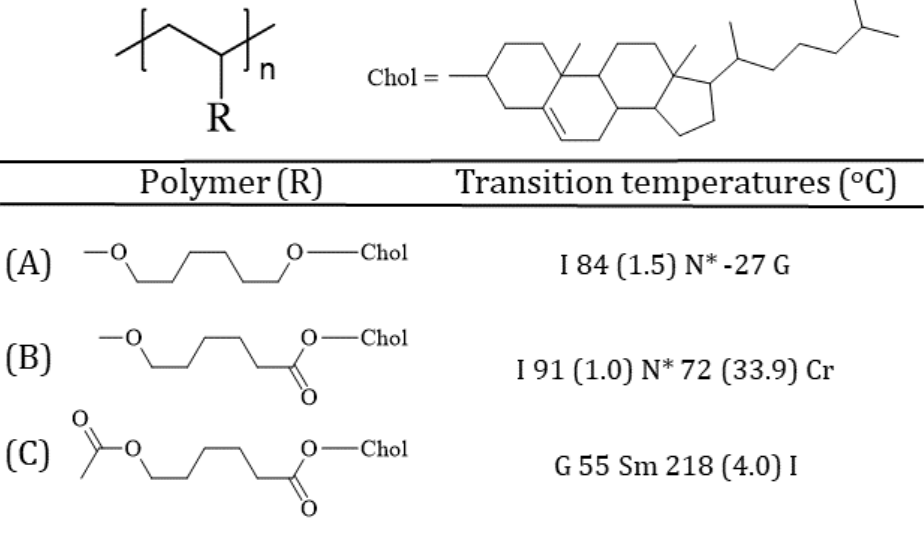
Figure 2. An example of the influence of chemical differences in the spacer connecting the backbone and the cholesteryl mesogen, on the liquid crystallinity of the material. The introduction of each of the ester groups ( A – C ) gradually increases the relative stiffness of the backbone. N*—chiral nematic, I—isotropic, G—glass, Cr—crystal and